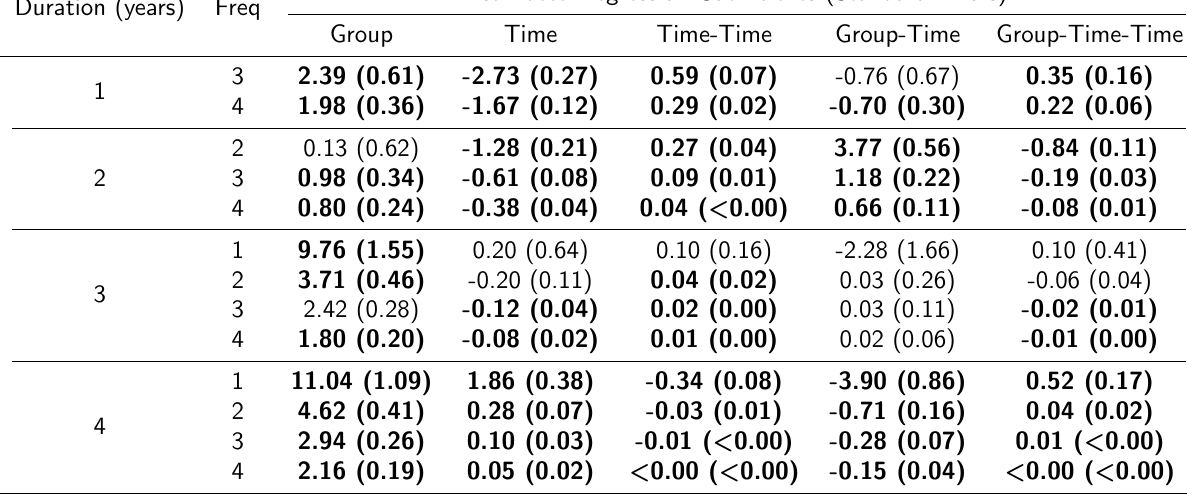
Table 1: Estimated regression coefficients (standard errors) for a generalized linear model applied to administrative health data for combinations of study duration and frequency of outcome measurements per year; model contained coefficients to estimate the quadratic trend over time